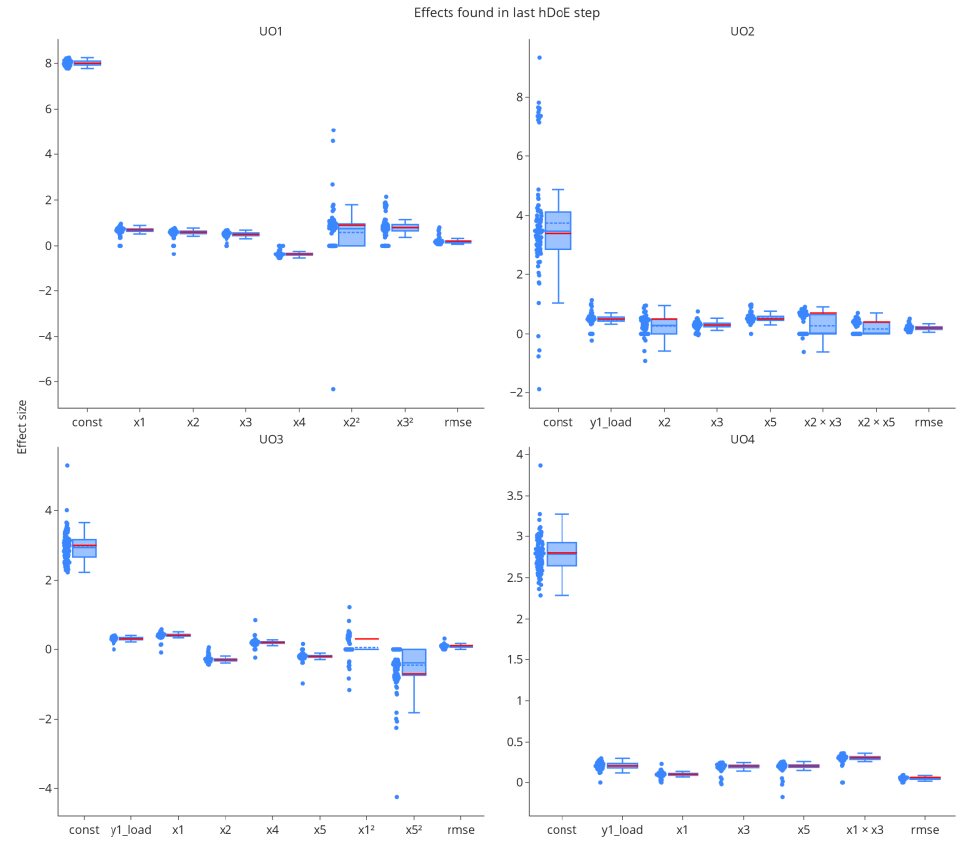
Figure 8. The distribution of effects found by stepwise variable selection at the last hDoE step. Each point represents the effect size in one of the 100 repetitions of the simulation study. The RMSE was added as an estimator of residual error.